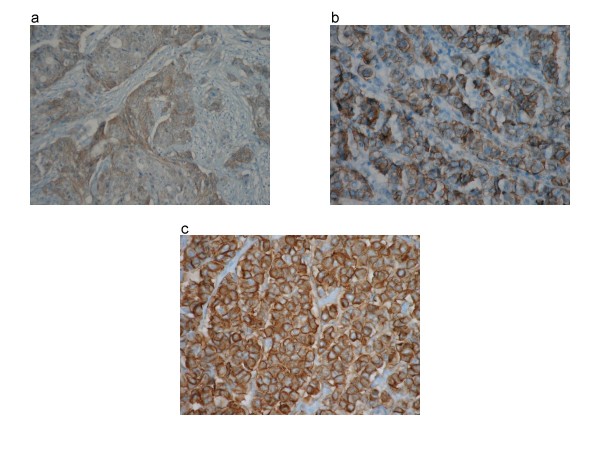
Immunohistochemical staining for HER-2/neu (Haematoxylin & eosin, magnification × 200). Breast cancer cells were used as a positive control (not shown). a.) Faint membrane staining is shown in > 10% of tumour cells (1+). b.) Weak to moderate staining of the entire membrane (2+). c.) Strong staining of the entire membrane in > 10%.